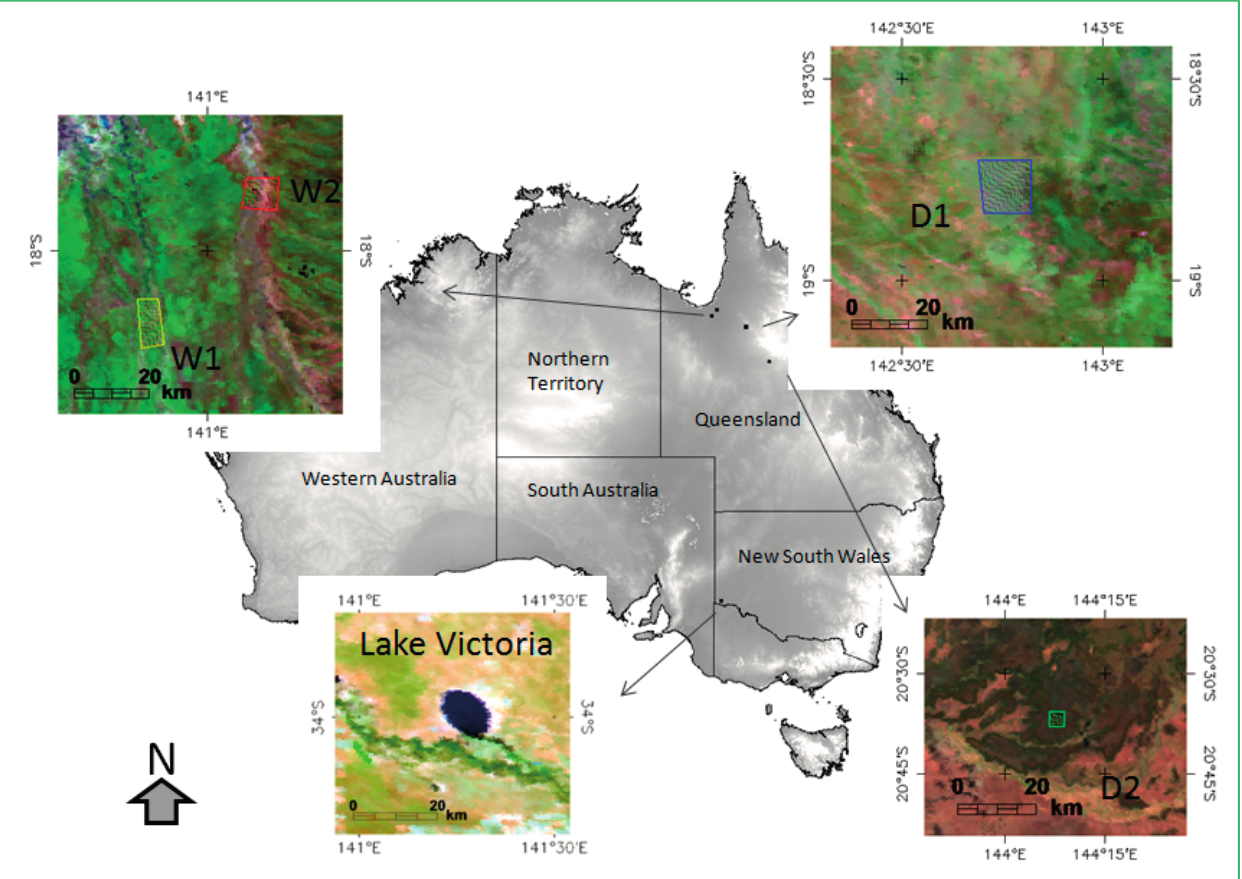
Figure 1. Locality map of the two dry (D1 and D2) and two wet (W1 and W2) sites, as well as Lake Victoria,